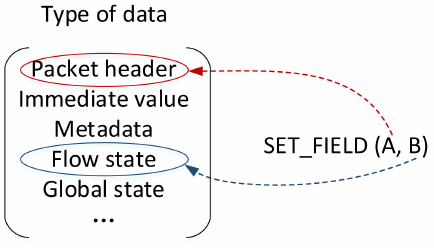
Figure 4. Changing the types of instruction parameters to enable data interoperability across several data types.